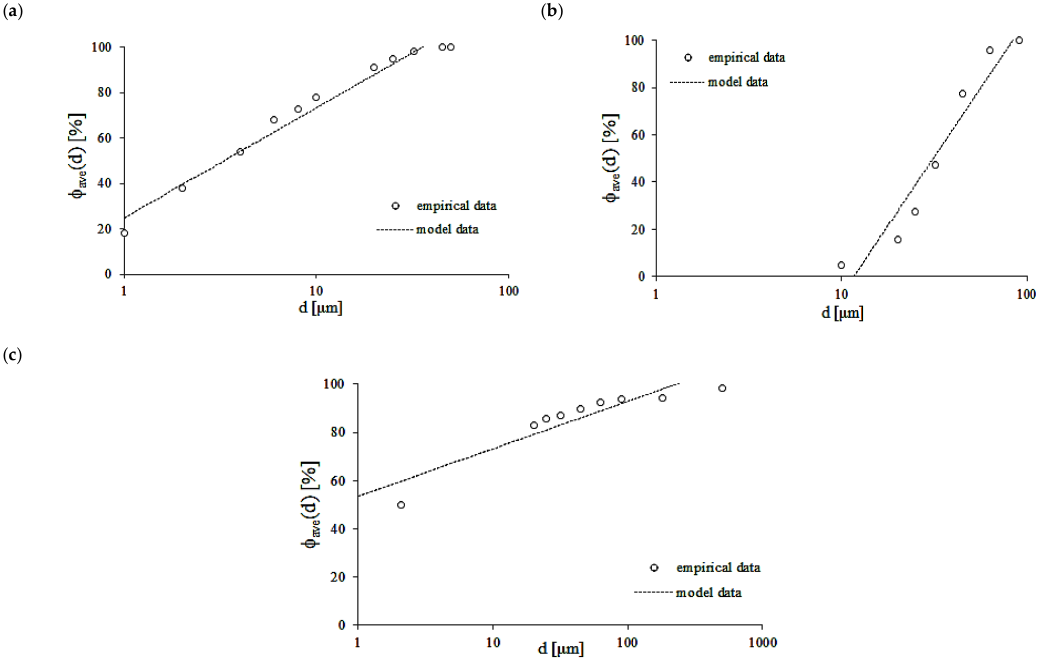
Figure 8. Results of the average particle distribution of the gypsums tested using laser diffraction: ( a ) building gypsum, ( b ) synthetic gypsum before calcination, ( c ) synthetic gypsum after calcination.